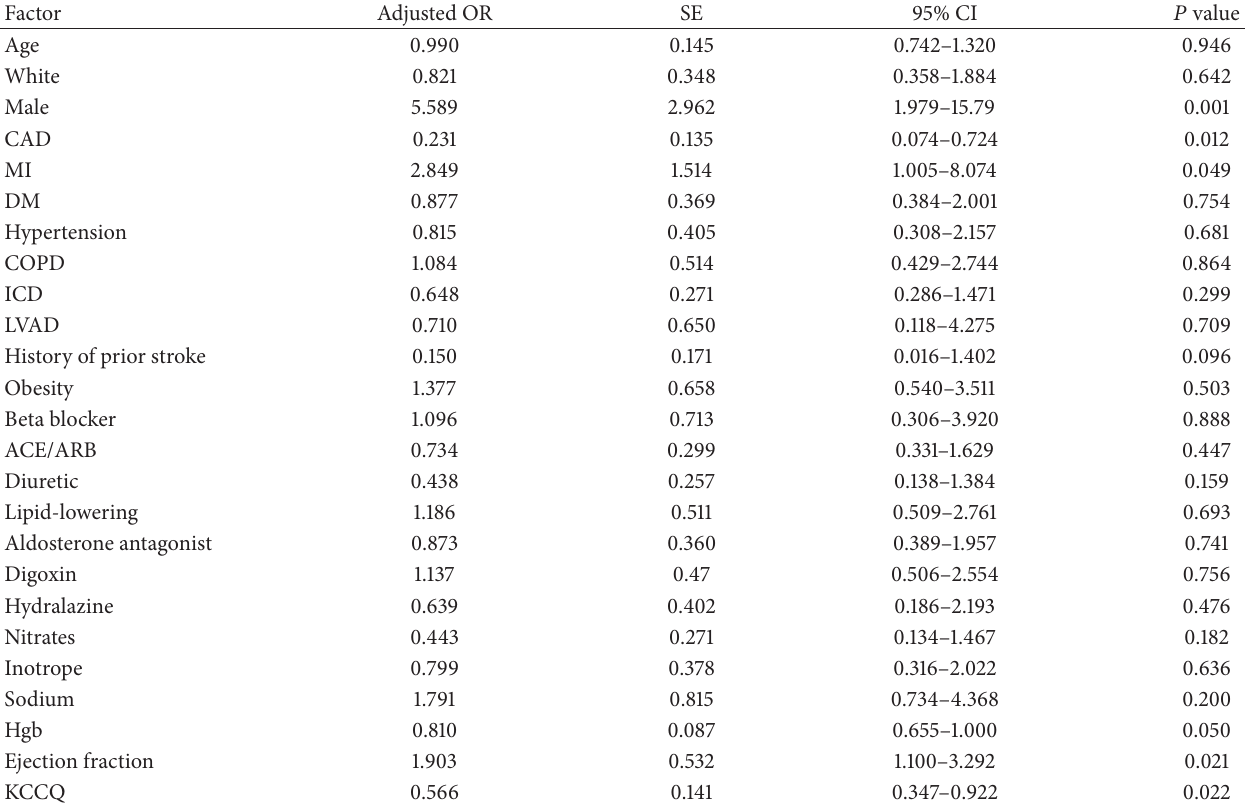
Table 3: Summary of multivariate analysis investigating the effects of demographic characteristics, medical history, discharge medication,